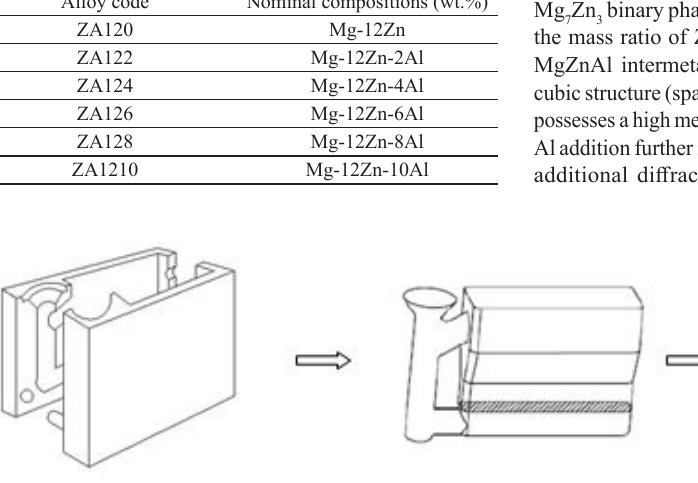
Figure 1 - Schematic for permanent mold, ingot and dimension of tensile sample (unit: